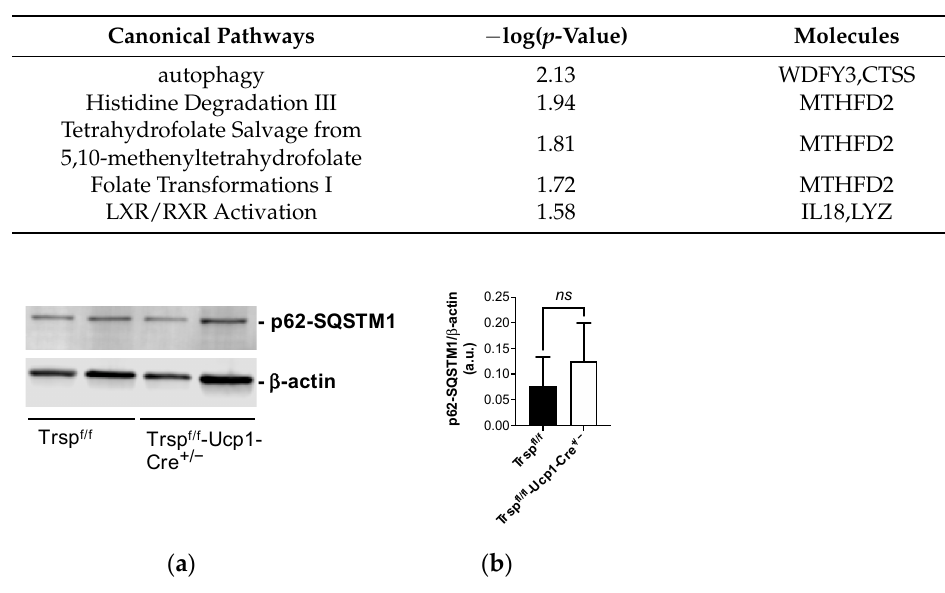
( d ) Figure 7. Gene expression changes in Trsp f/f -Ucp1-Cre +/ − - mice at room temperature and after acute cold exposure. ( a ) Venn diagram of microarray data sets, showing the number of genes differentially expressed between Trsp f/f -Ucp1-Cre +/ − and